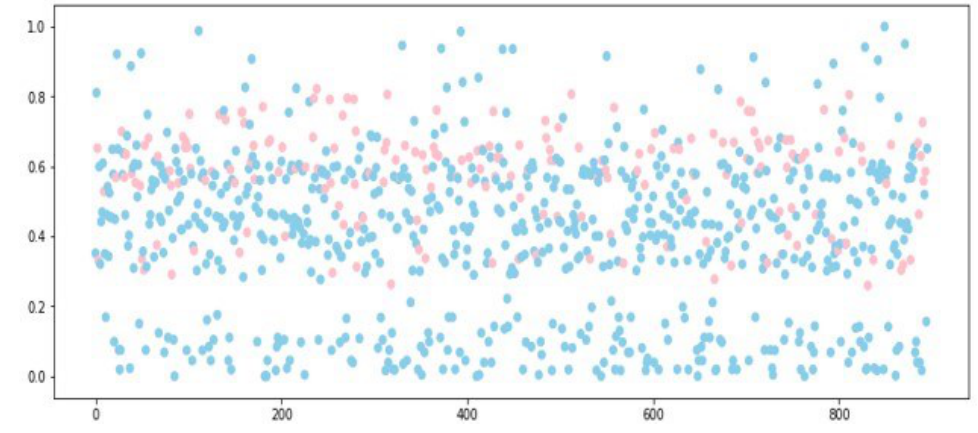
Figure 7. Anomaly score point scatter using ReLU as an activation layer.